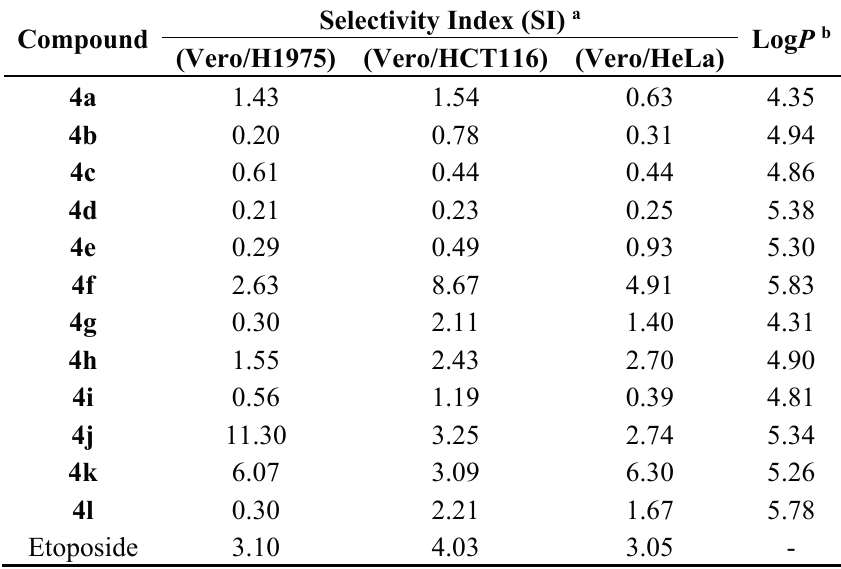
Table 2. Selectivity Index and log P of compounds 4a – 4l .